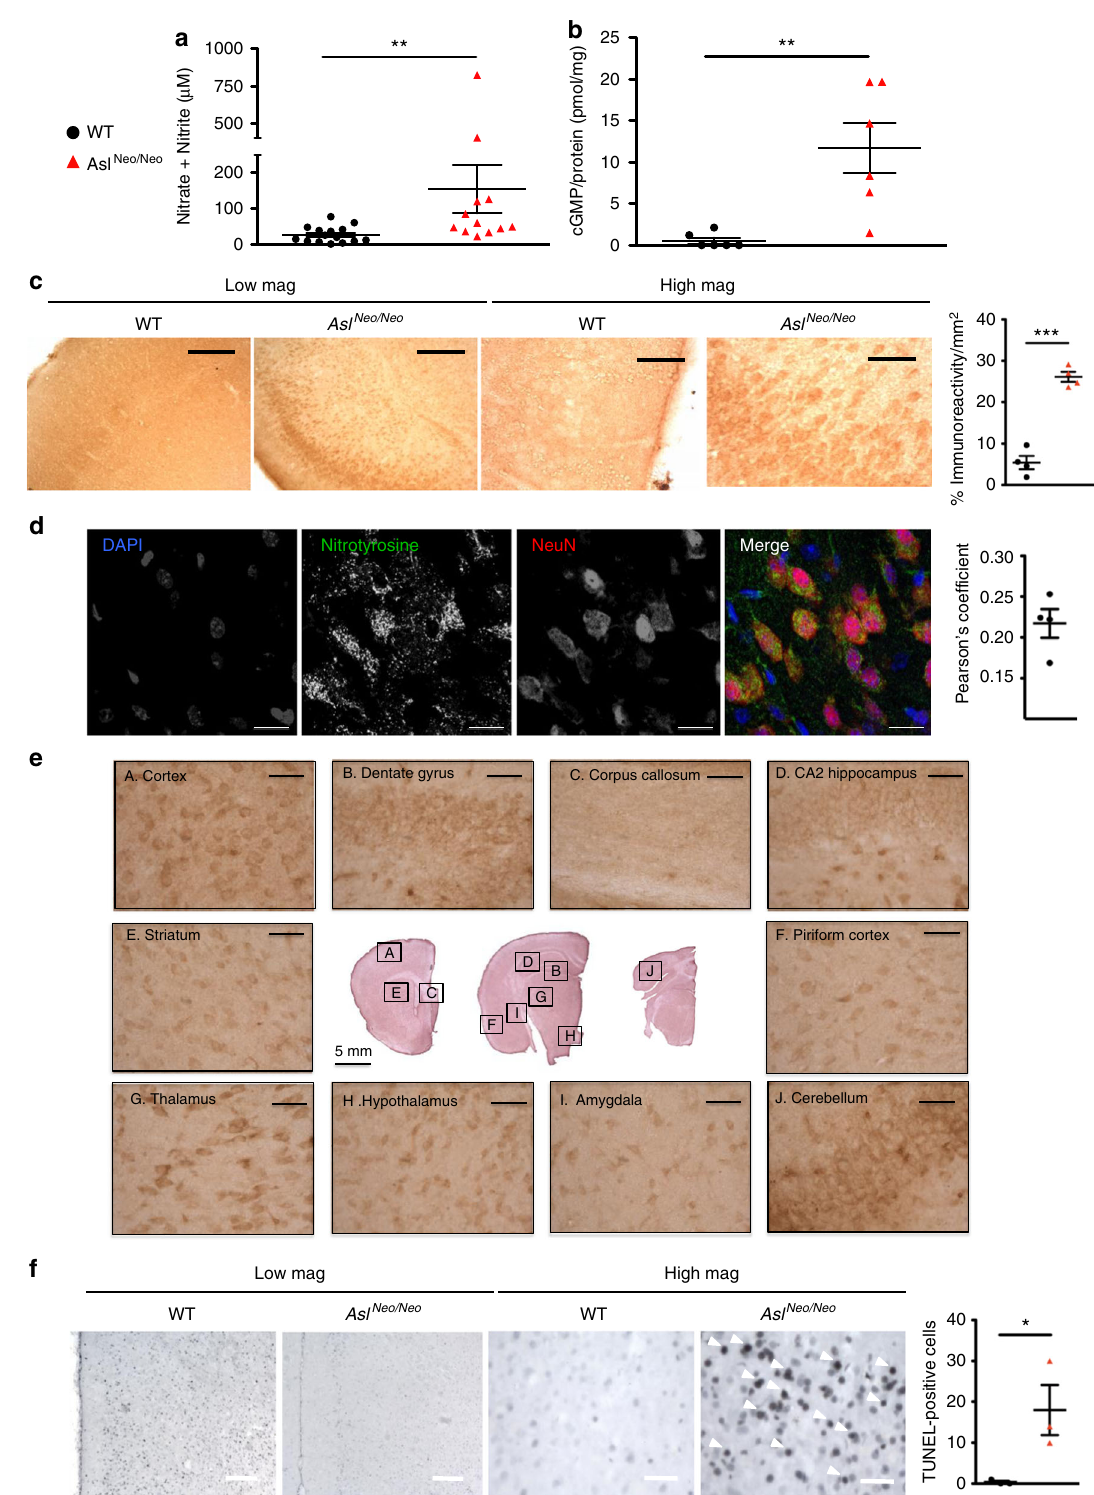
Fig. 1 Neuronal oxidative/nitrosative stress is a component of the neurological disease in Asl Neo/Neo mice. a Nitrite/nitrate levels ( n = 12 – 15) and b cyclic GMP ( n = 6) in brain homogenates of 2 – 4-month-old mice. c Nitrotyrosine immunostaining was increased in cortical sections in cells morphologically suggestive as neurons. d Neuronal nitrotyrosine staining was con fi rmed by immuno fl uorescence ( n = 3). Colocalisation between nitrotyrosine and NeuN was measured by Pearson ’ s coef fi cient. e Localisation of nitrotyrosine was diffuse, predominant in cortical and subcortical areas and was minimal in the cerebellum. f Increased cell death rate in cortex was observed in Asl Neo/Neo mice compared to WT ( n = 4). Horizontal lines display the mean ± standard error of the mean (SEM). ns = not signi fi cant. Unpaired two-tailed Student ’ s t test * p < 0.05, ** p < 0.01, *** p < 0.001. a Graph displays not transformed data. Log-transformed data were used for statistical analysis. Scale bars: c low and high magni fi cation: 500 and 125 μ m, respectively; d 25 μ m; e 125 μ m; f low and high magni fi cation: 500 and 125 μ m, respectively. Figures show representative images and d representative